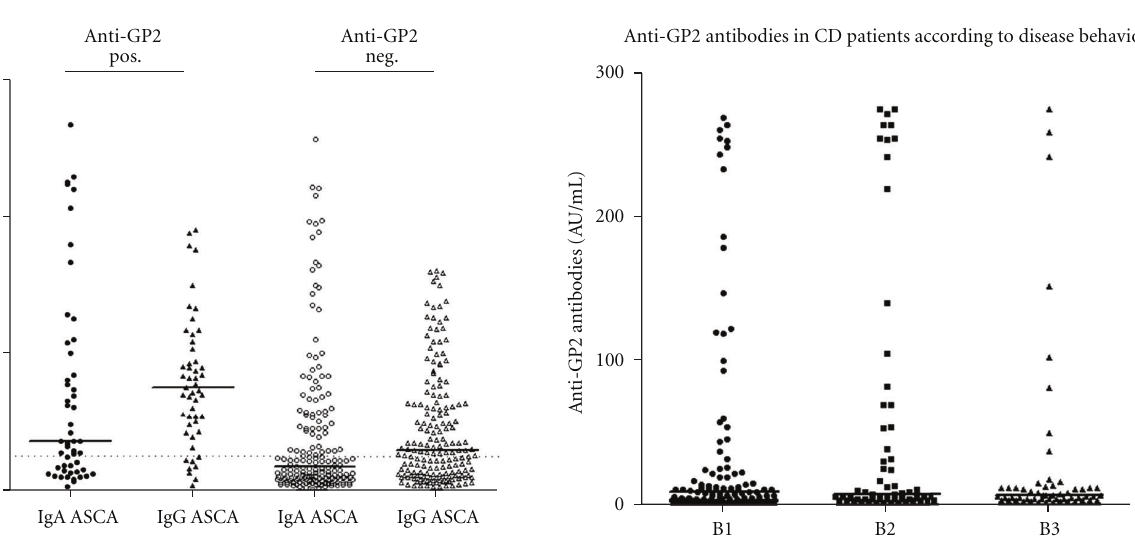
Figure 5: Comparison of IgG anti-GP2 antibodies in patients with Crohn’s disease (CD) stratified in accordance to disease behaviour (Montreal Classification, B1, B2, and